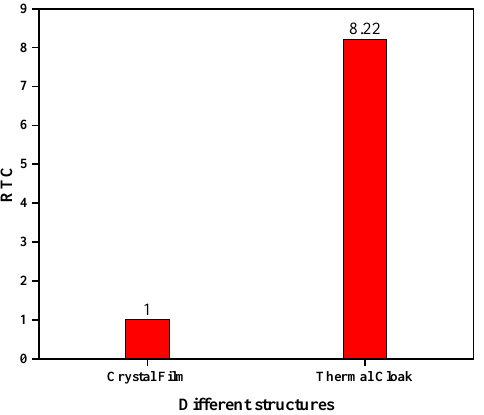
Figure 5. The RTC with different structures at 600 ps.